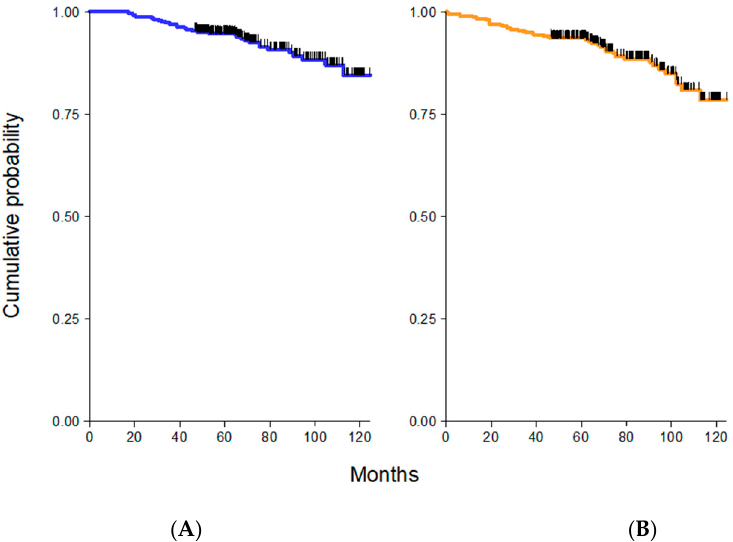
Figure 3. Five-year overall survival (OS), excluding patients with follow-up less than 12 months and with second tumors, was equal to 95% ( A ) and five-years progression free survival (PFS) was equal to 90% ( B ).